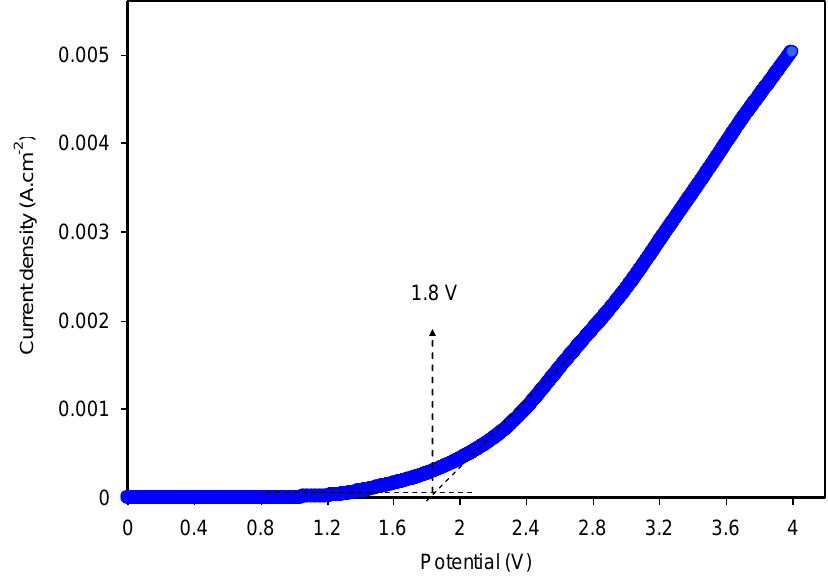
Figure 8. LSV curve for the highest conducting CS: Dextran: NH 4 I electrolyte at a scan rate 100 mV/s.